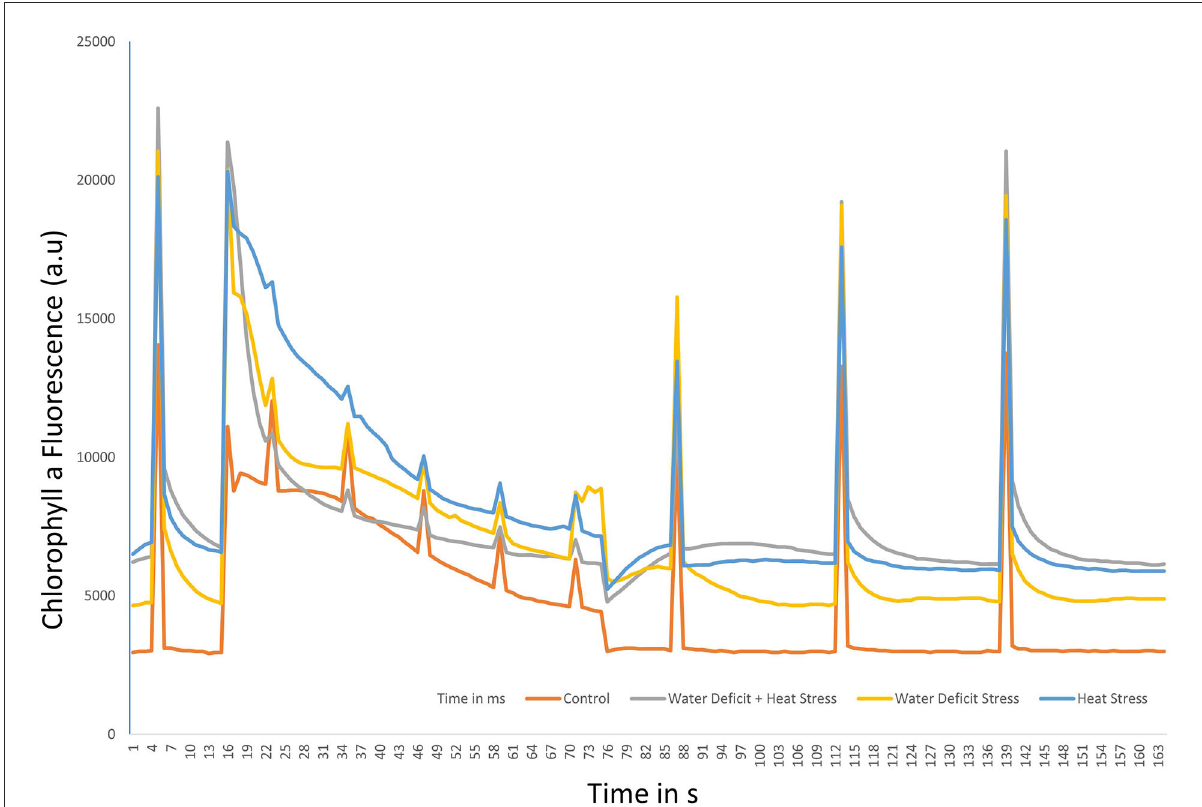
FIGURE5 Non-photochemical Quenching (NPQ) under water-deficit stress and heat stress in isolation and in combination in ICMH356 variety pearl